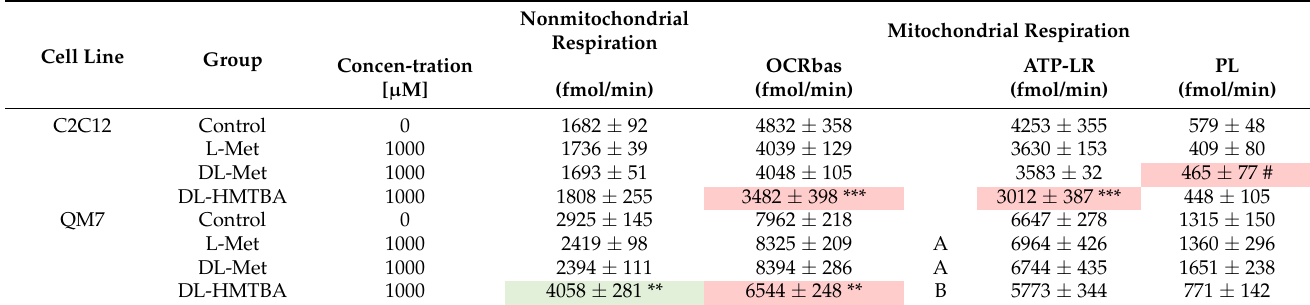
Table 2. Effects of supplementation with 1000 µ M of L-Met, DL-Met, or DL-HMTBA on bioenergetics and mitochondrial function of C2C12 and QM7